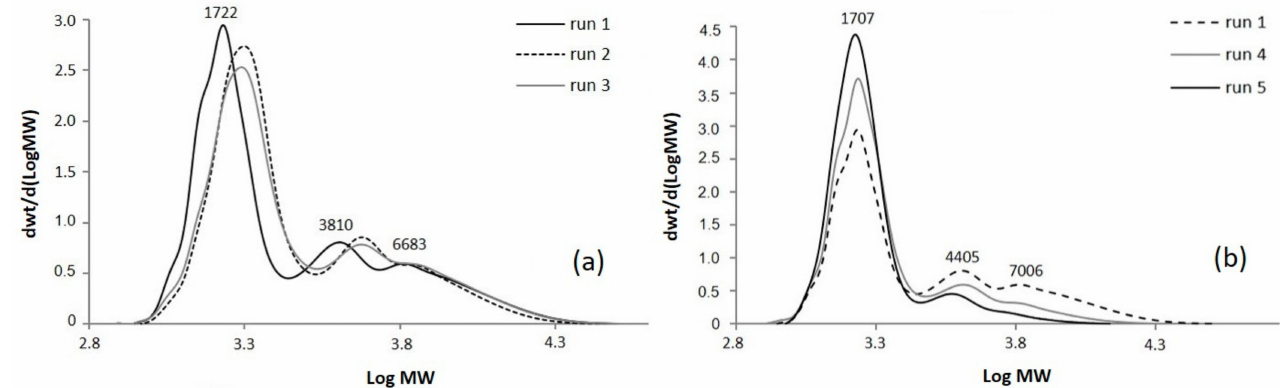
Figure 2. SEC (size exclusion chromatography) chromatograms of bio-polyols from ESO and caprylic acid: ( a ) with different epoxy/carboxyl ratio and ( b ) effect of the presence of TEA (triethylamine) on molecular